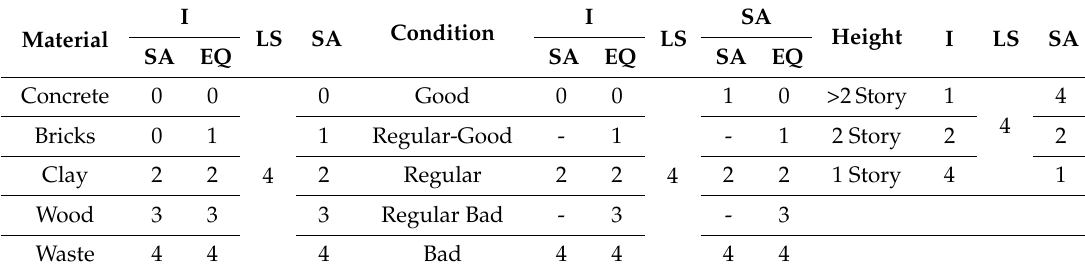
Table 5. Housing level of vulnerability to natural hazards in San Antonio (SA) and El Quisco (EQ) (I: inundation due to tsunami and fluvial flood, LS: landslide, SA: seismic amplification). Note that values may differ for the same hazard among the